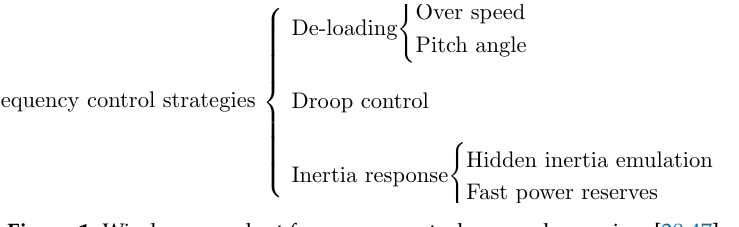
Figure 1. Wind power plant frequency control: general overview